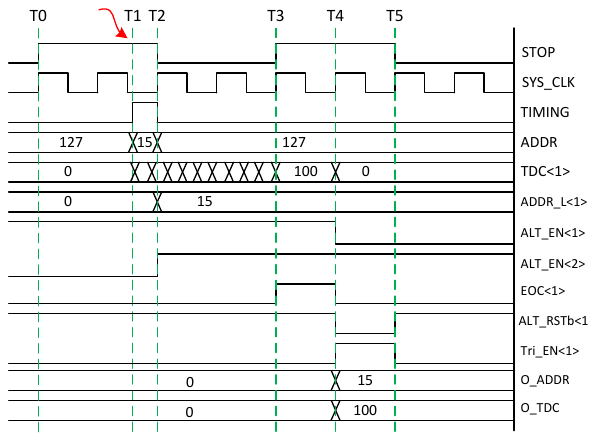
Figure 6. ALTDC timing diagram associated with photon detection by ALTDC<1>.